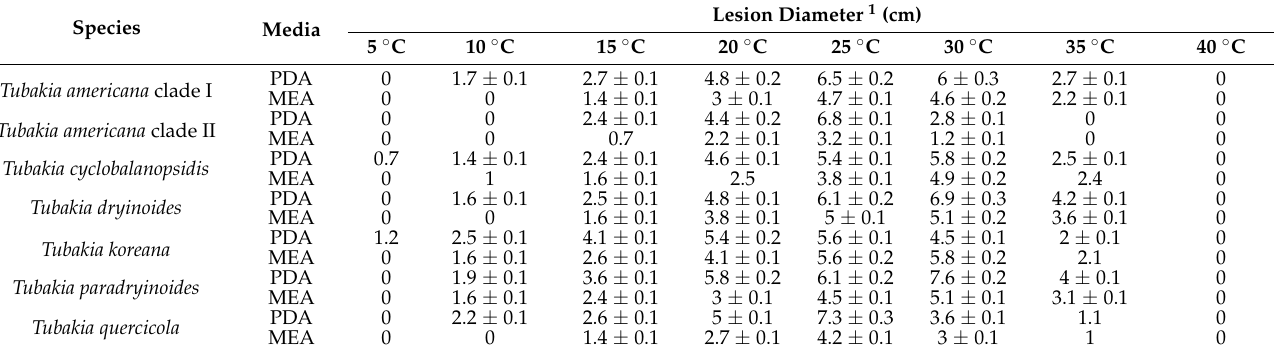
Table 3. An overview of colony diameters at various temperatures.